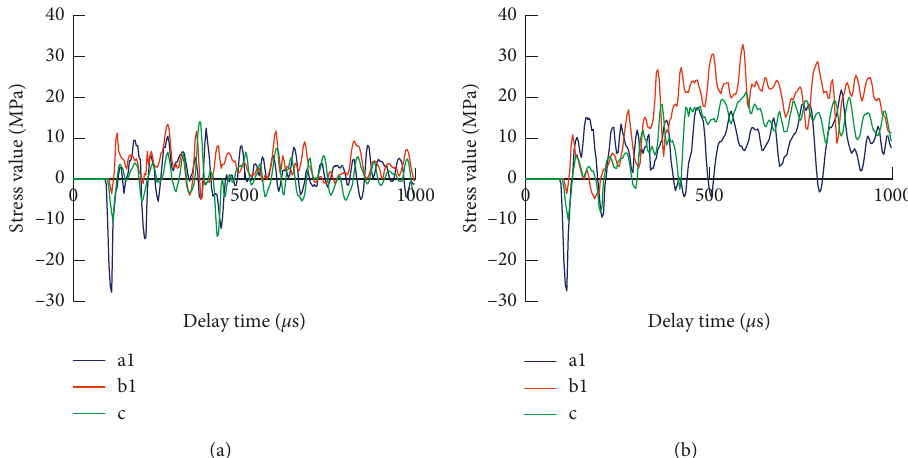
Figure 16: Stress concentrate curve of elements of TBH hole wall before TBH initiation when delay time is 1ms. (a) The PBH is a round hole. (b) The PBH is a notch